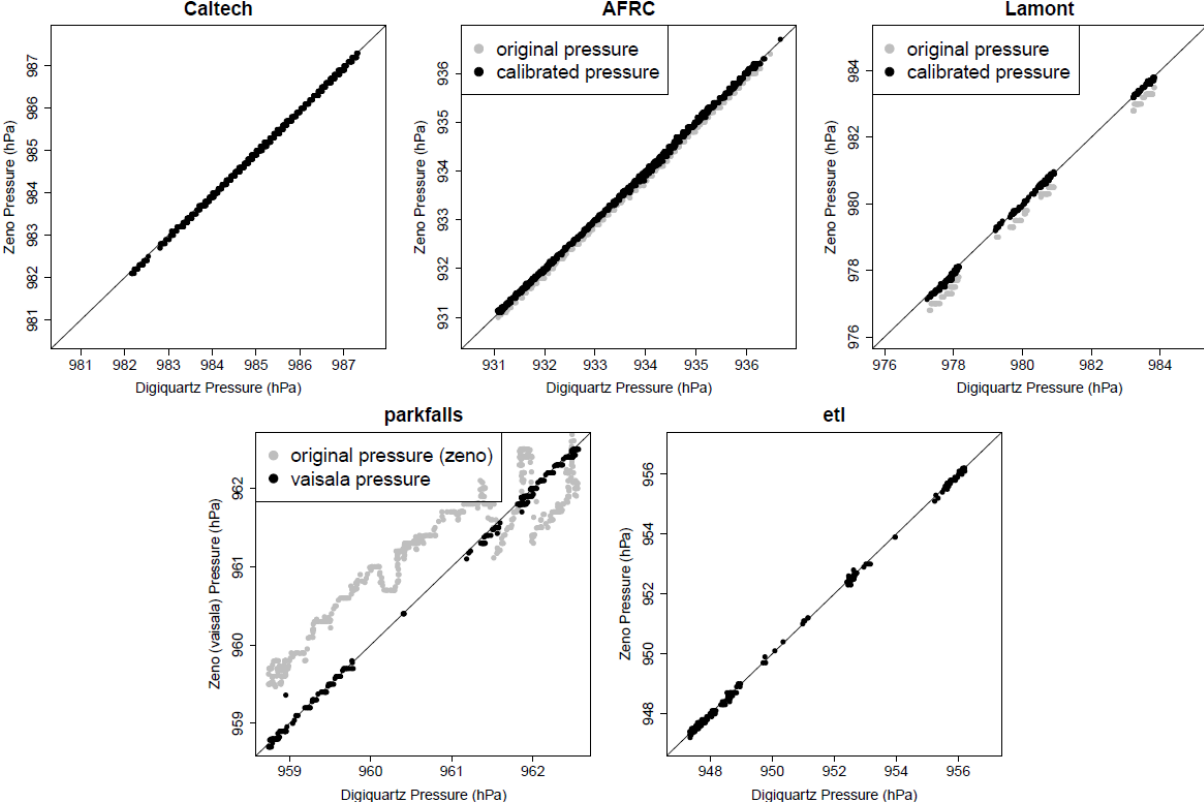
Figure B1. Surface pressure used for the EM27/SUN and TCCON retrievals compared against the standard Digiquartz pressure sensor. At AFRC and Lamont, a small bias was added to the EM27/SUN pressure to match the Digiquartz pressures. At Park Falls, Vaisala WXT536 pressures are also